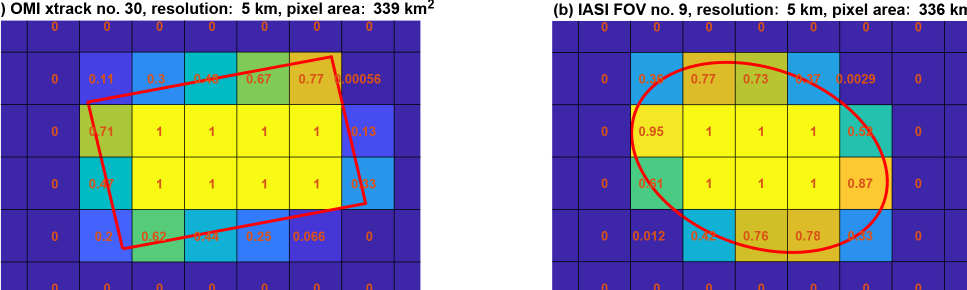
Figure 3. Tessellation process for OMI (a) and IASI (b) pixels. The IASI pixel is approximated by a 100-vertex polygon. The overlapping area ( S(i,j) ) between satellite pixel i and grid cell j is labeled at grid cell center, normalized by grid cell area (25km 2 ). Across-track: